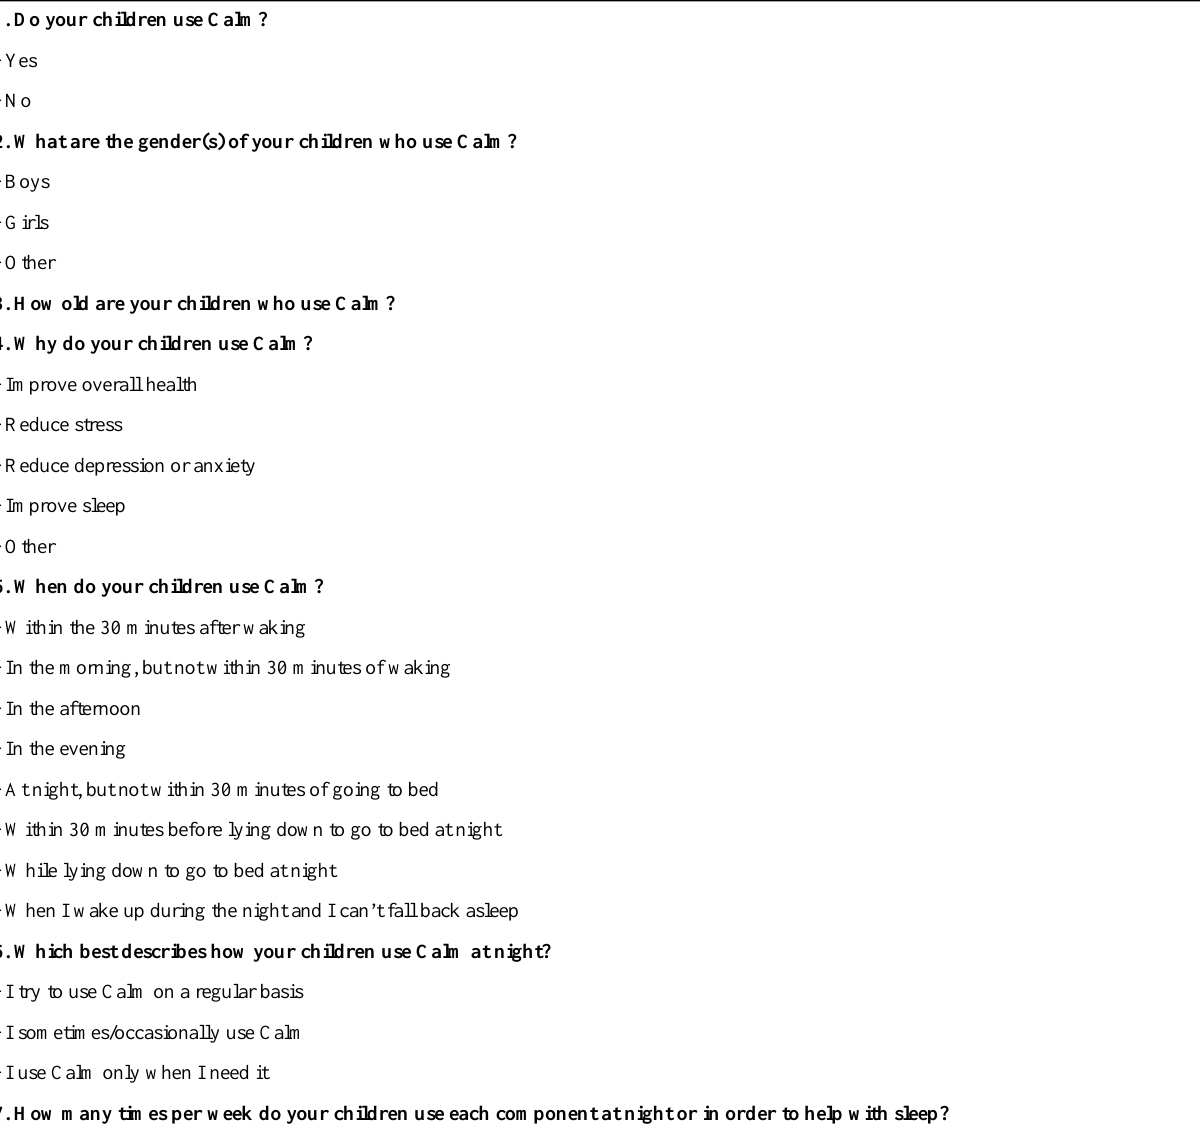
Textbox 1. Survey questions for